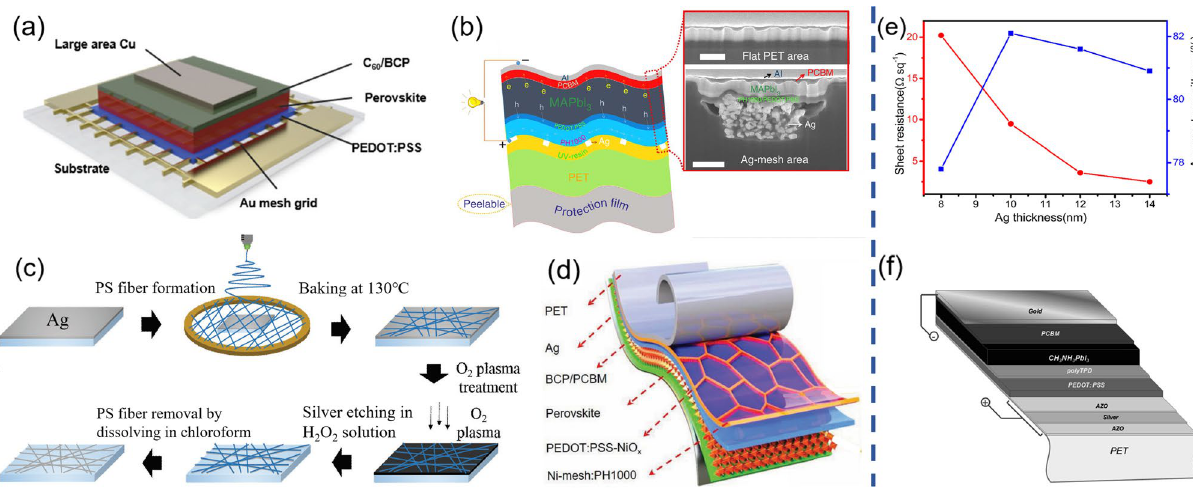
Fig. 6 a Schematic layout of FPSCs based on Au mesh/PEDOT:PSS electrodes. Reproduced with permission from Ref. [22]. Copyright 2019, Royal Society of Chemistry. b Diagram of the FPSC based on the Ag-mesh/PH1000 electrode and the corresponding cross-section SEM image. Reproduced with permission from Ref. [126]. Licensed under a Creative Commons Attribution (CC BY) license. c Schematic of fabricating Ag network electrode. Reproduced with permission from Ref. [131]. Copyright 2017, John Wiley and Sons. d Schematic illustration of FPSCs based on PET/Ni-mesh/PH1000 electrode. Reproduced with permission from Ref. [134]. Licensed under a Creative Commons Attribution (CC BY) license. e The dependence of sheet resistance and average transmittance to Ag thickness in OMO structure electrode. Reproduced with permission from Ref. [137]. Copyright 2019, Elsevier. f Structure of FPSCs based on the AZO/Ag/AZO electrode. Reproduced with permission from Ref. [139]. Copyright 2014, Royal Society of